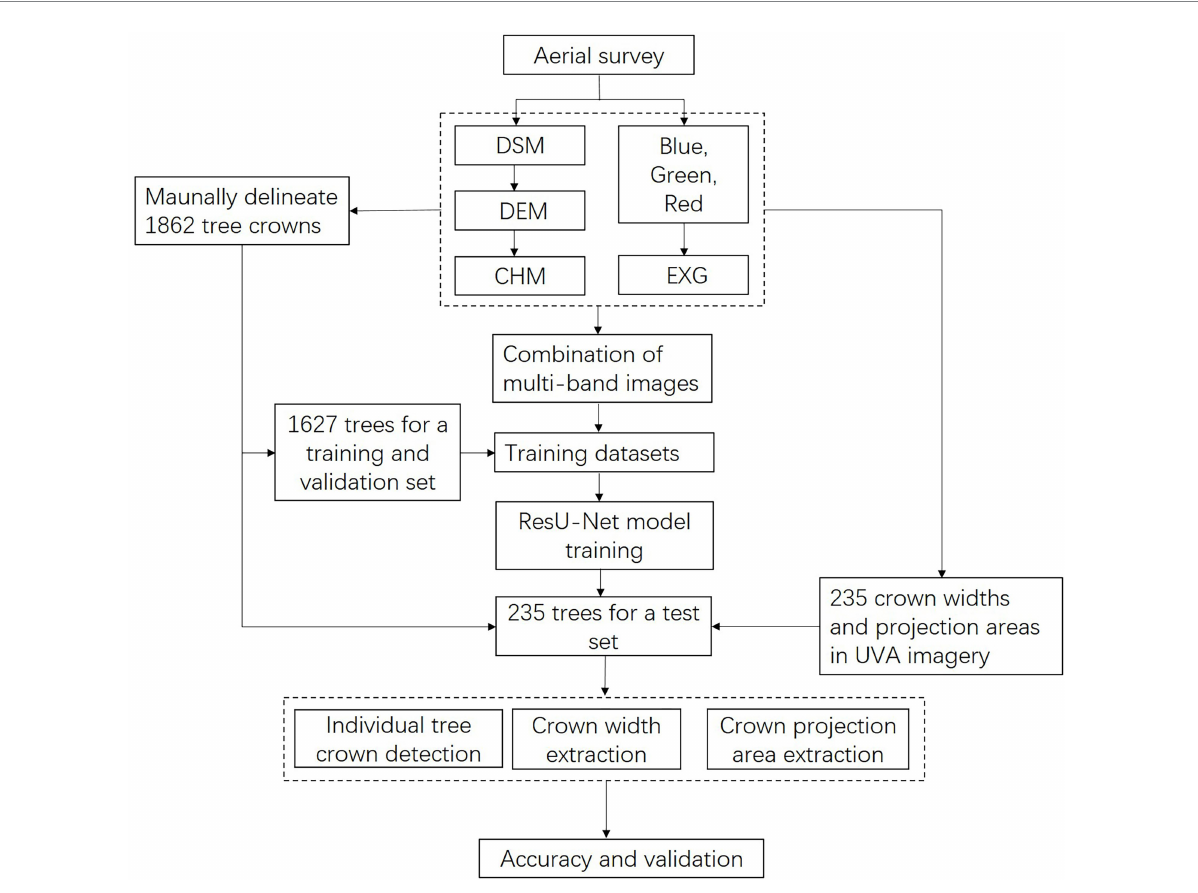
FIGURE 1 Flowchart of individual tree-crown detection, crown width, and projection area assessment in this study. DSM, digital surface model; DEM, digital elevation model; CHM, canopy height model; EXG, excess green